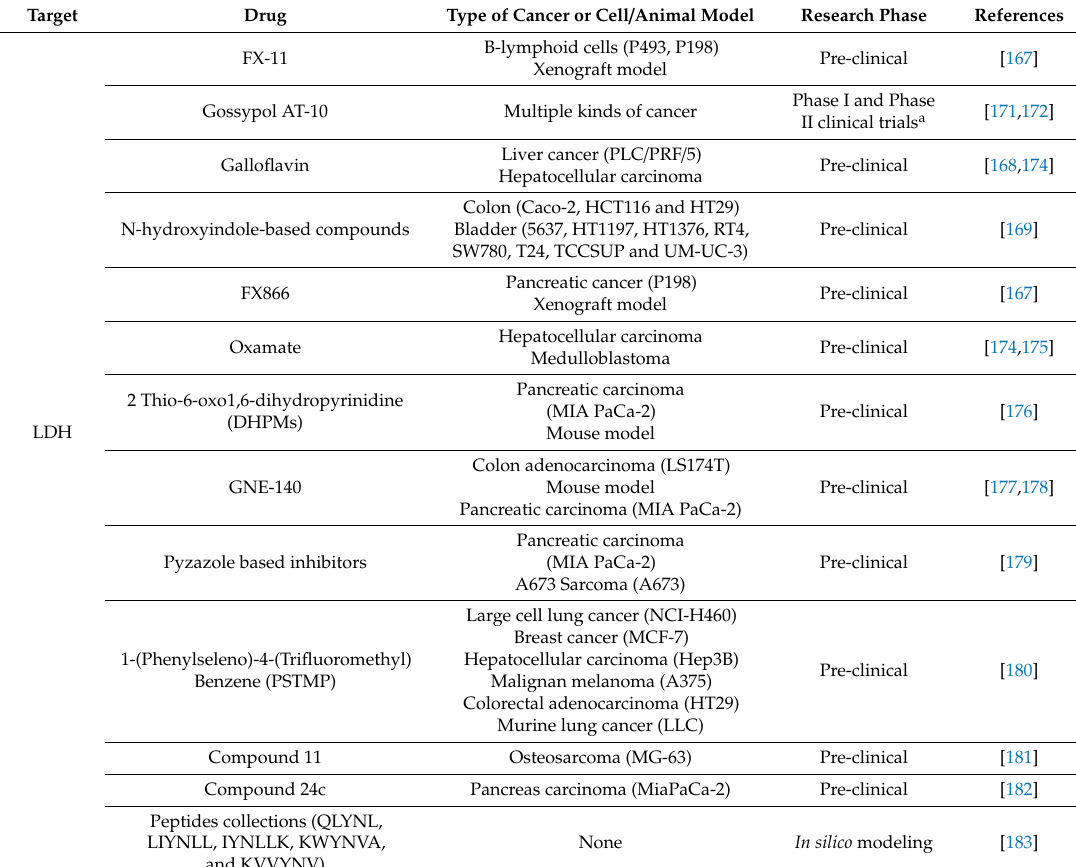
Table 1. Compounds to inhibit lactate